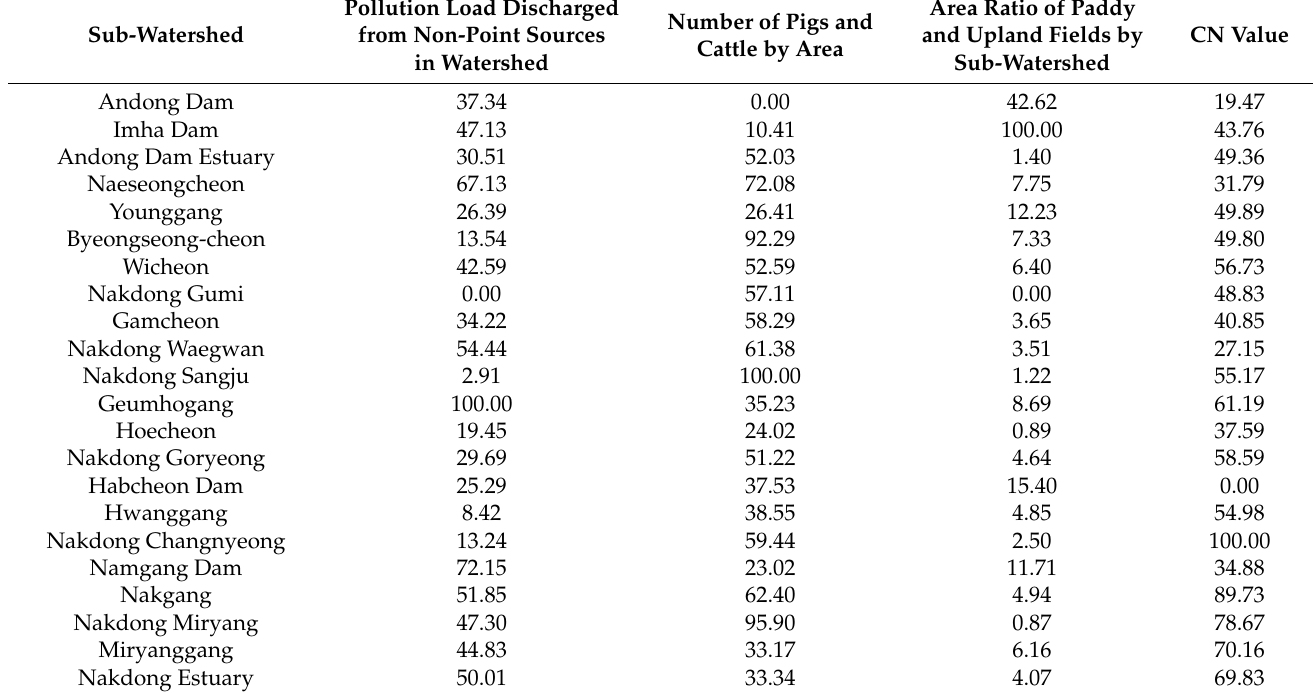
Table 9. Standardized indices for climate change sensitivity in SSP